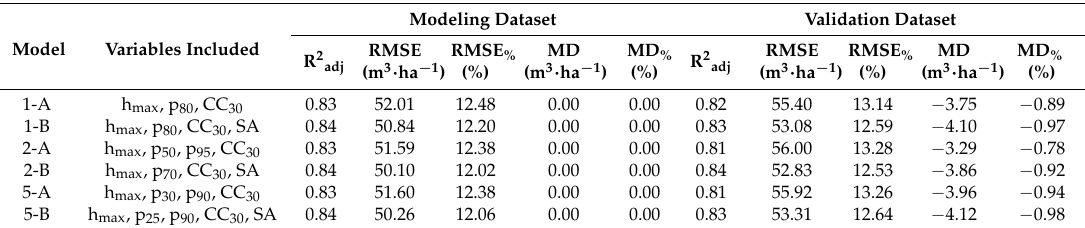
Table 6. Results of stepwise regression (modeling dataset) and validation results (validation dataset) for six selected stand-level volume models described in Table